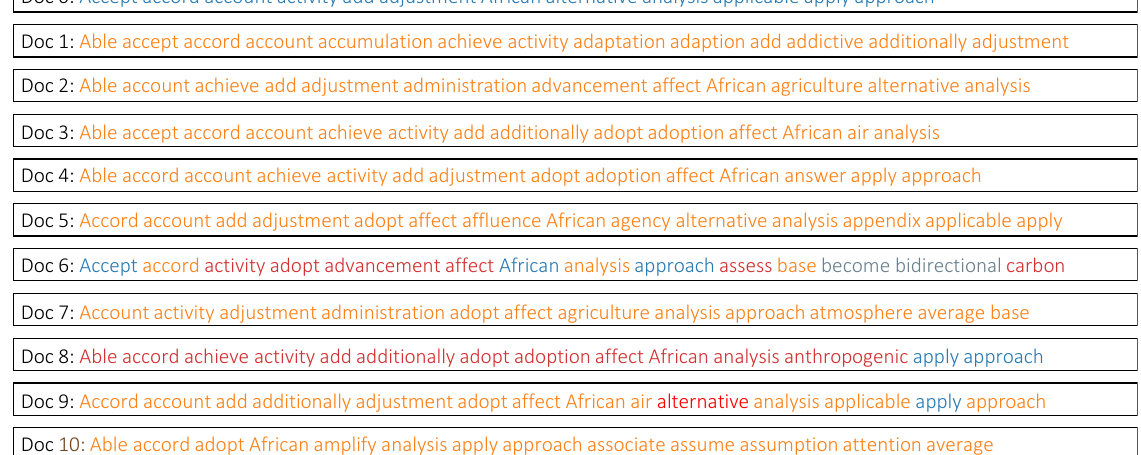
Figure 5. Sentence topic coloring for